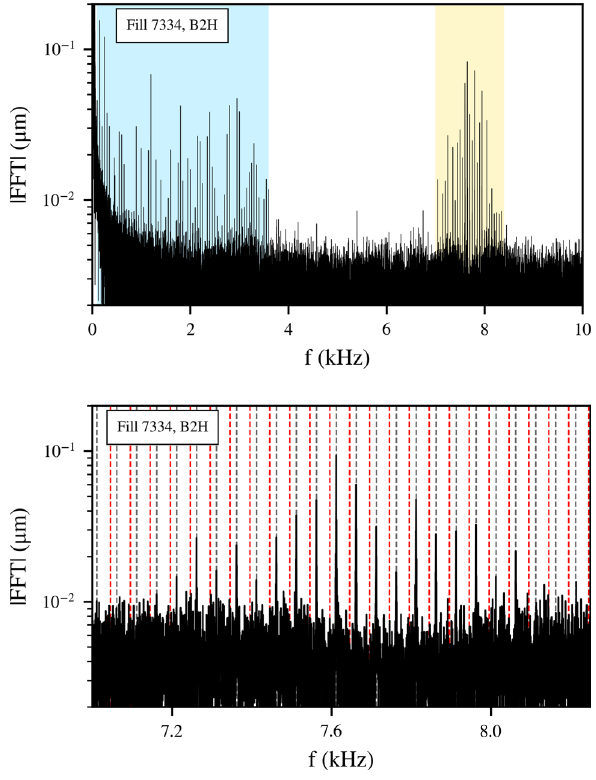
FIG. 4. The horizontal spectrum of Beam 2 at Flat Top for a frequency range up to 10 kHz (top), with the low and high- frequency cluster indicated by the blue and orange span, respectively, and centered around the high-frequency cluster (bottom). The red and gray dashed lines represent the expected − f position of aliased ( f 50 ) and physical 50 Hz harmonics rev ( f 50 ), respectively.